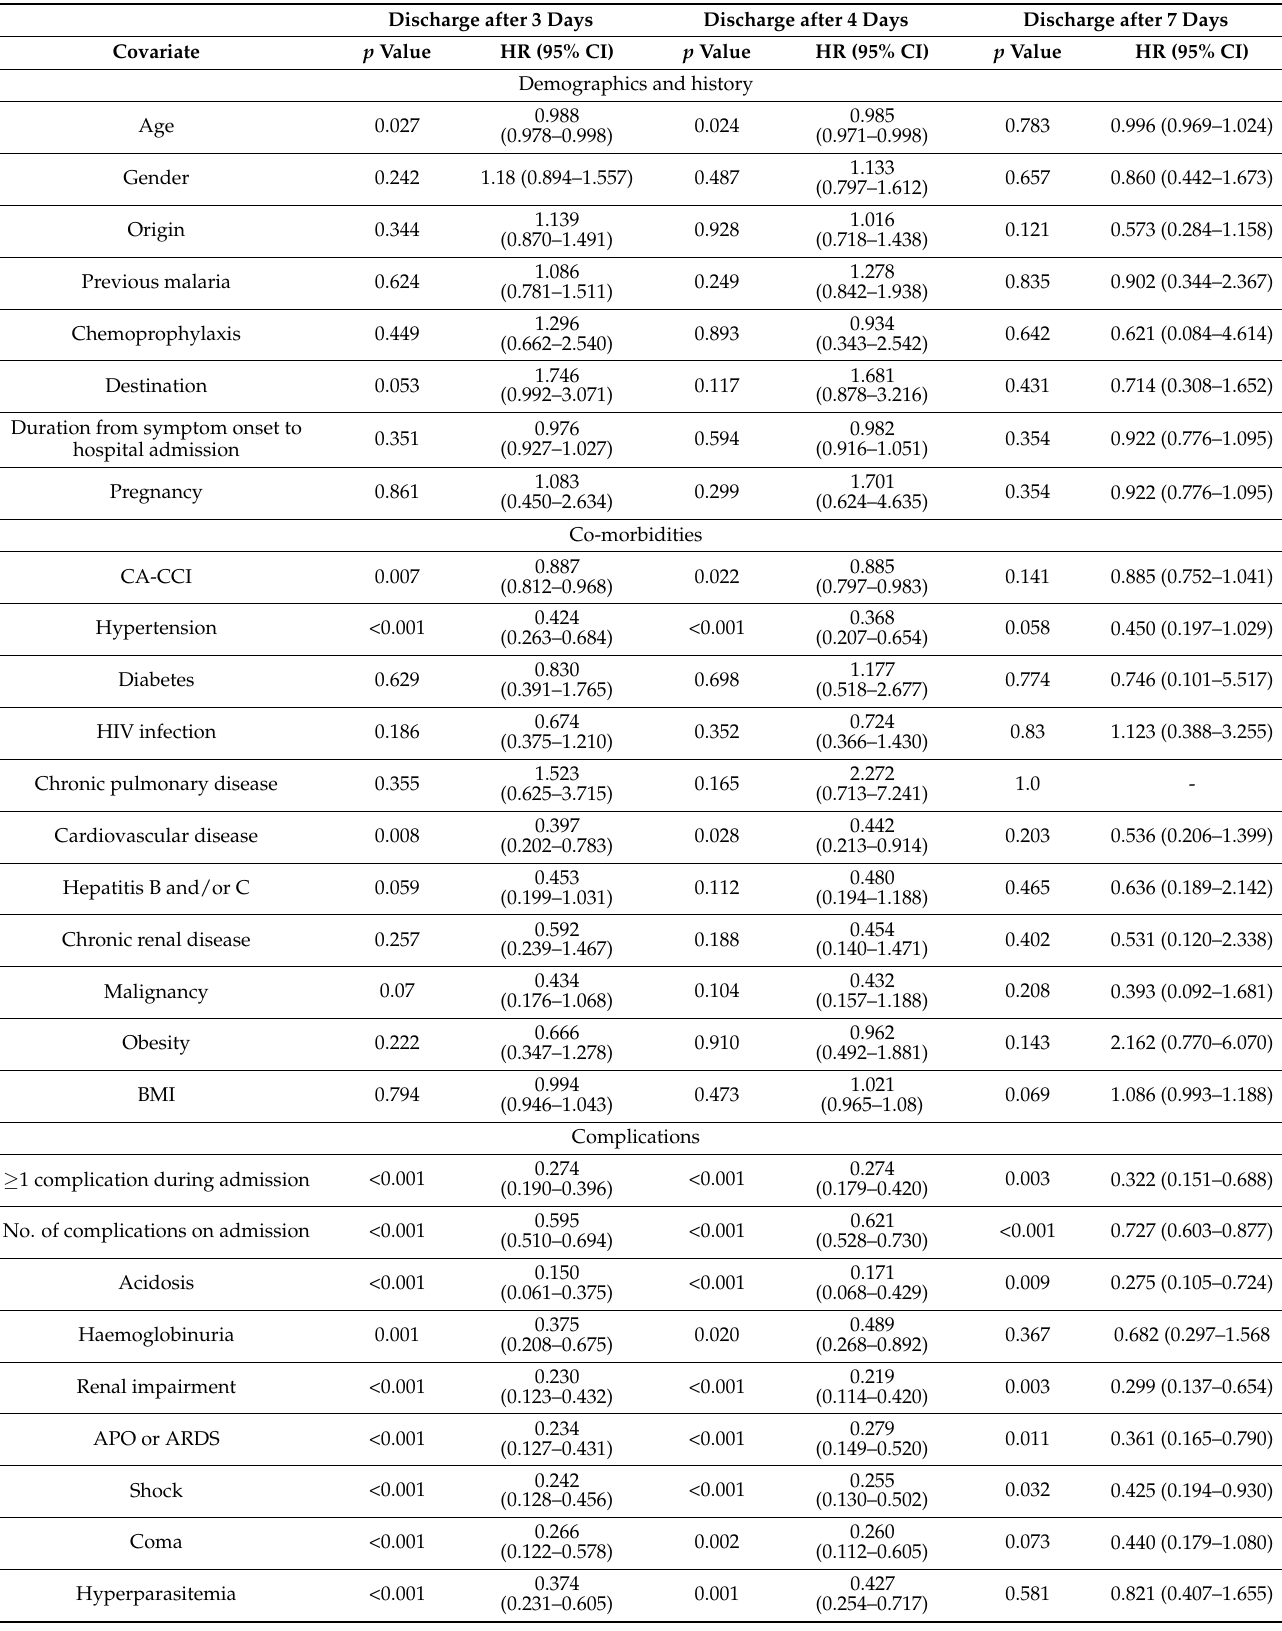
Table 3. Univariate analysis of factors associated with hospital length of